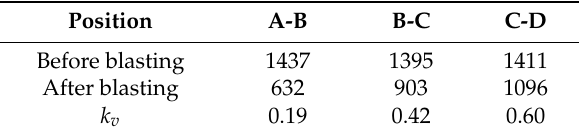
Table 2. Measured longitudinal-wave velocity (m/s) and calculated k v .